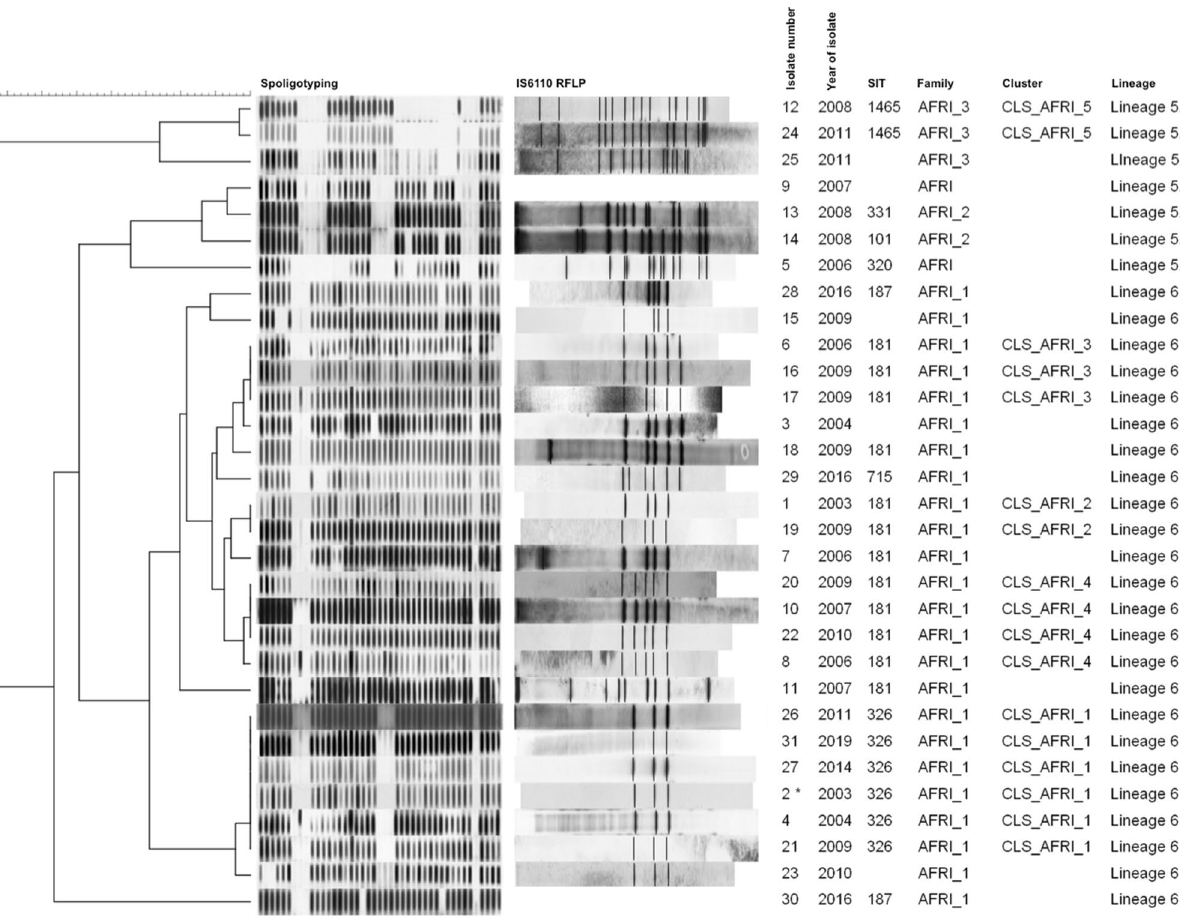
Figure 2. Dendrogram based on spoligotype patterns. The data shown are spoligotypes, IS 6110 -RFLP types, isolate number, year of isolation, SIT, family under SITVIT definition, and lineage of each M. africanum isolate in our population from 2003 to 2019. For two isolates, RFLP-type was not available, both showing a unique spoligotype belonged to AFRI and AFRI1 families. *Isolate 2 in CLS_AFRI_1 has a different location of one copy of IS 6110 despite sharing the RFLP pattern with the other five isolates included in its